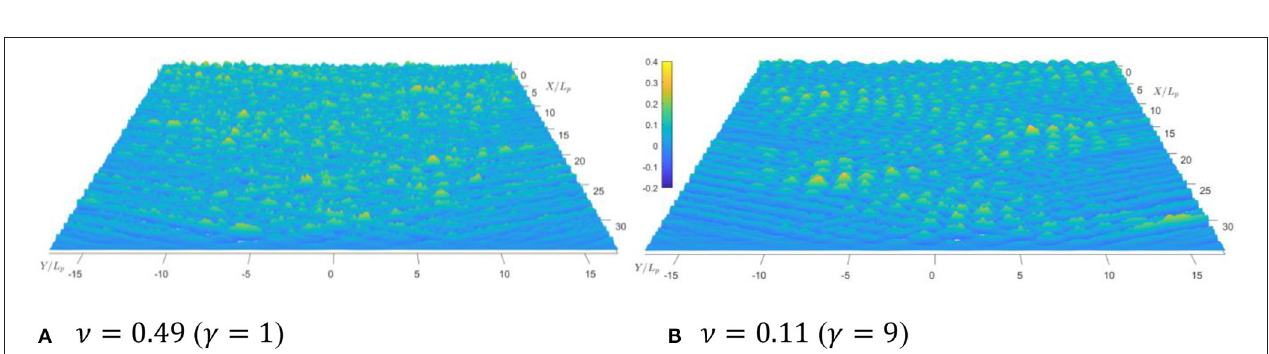
FIGURE 2 | Kurtosis along the center line of the domain Y 0. “Lab.”: Laboratory experiment results; “HOS”: Numerical results by using the HOS method; “ESBI”: = Numerical results by using the ESBI method for crossing sea; “ESBI-uni”: Numerical results by using ESBI for non-crossing unidirectional sea.